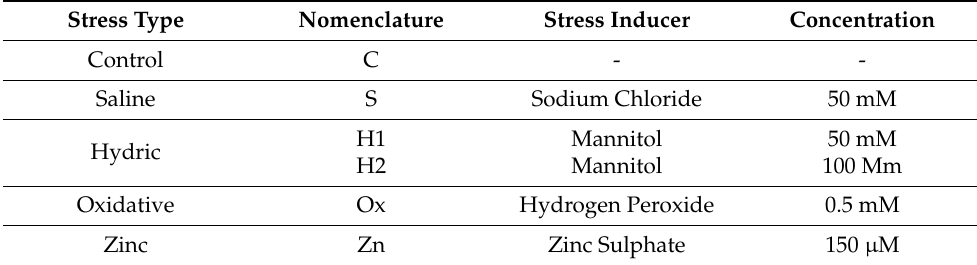
Table 1. Different conditions and stress inducers used to simulate abiotic